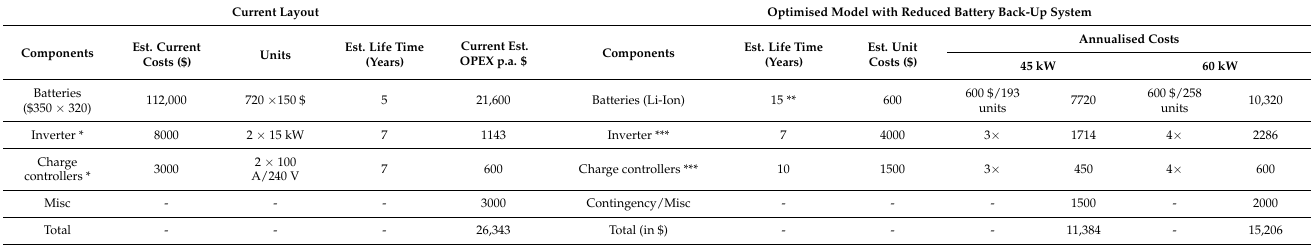
Table A6. Current and optimised technical layout and OPEX for Mpanta